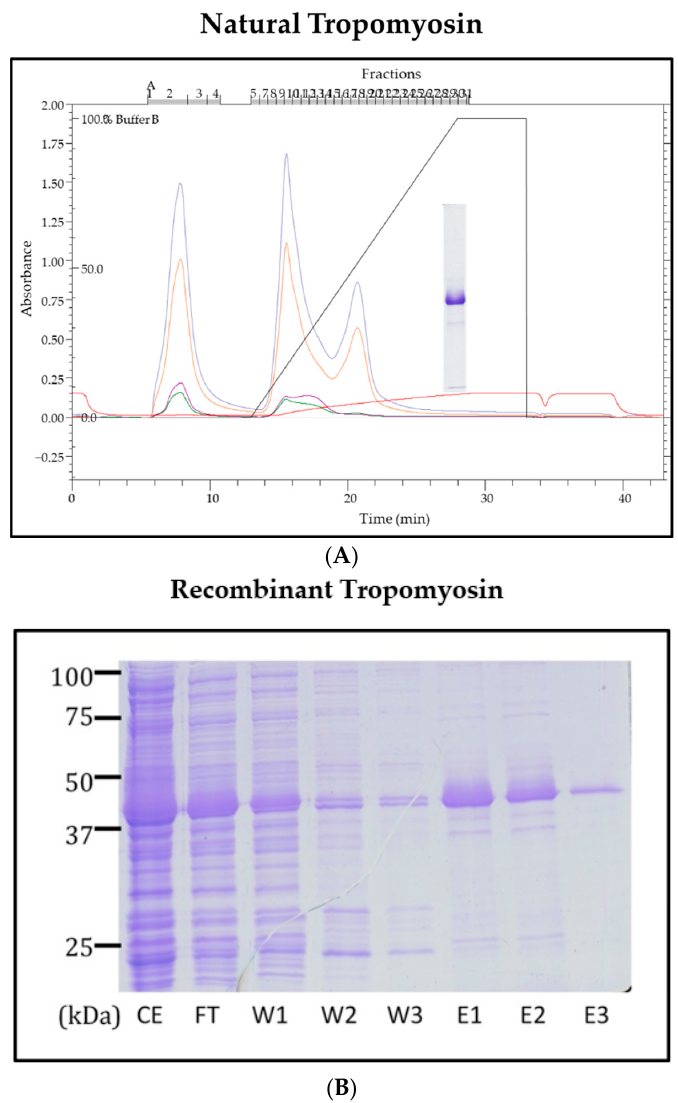
Figure 3. Purification profile of natural ( A ) and recombinant ( B ) tropomyosin of Pacific oyster. Natural tropomyosin was purified using CHT™ Ceramic Hydroxyapatite. The increase in the absorbance was measured at 280 nm (blue line) and 220 nm (red line) and 31 eluted fractions were collected and analysed by SDS-PAGE. The 17th, 18th, and 19th peak contained pure tropomyosin, appearing as a strong band at 39 kDa in the Coomassie-stained SDS-PAGE gel. Recombinant tropomyosin (3B) was purified using HisPur Ni-NTA with increasing concentration of imidazole. Purified tropomyosin was observed at 40 kDa due to six-His-tag fused to its N-terminal. Note for Figure 3B: CE = crude extract, FT = Flow through, W = Wash, E = Eluent.